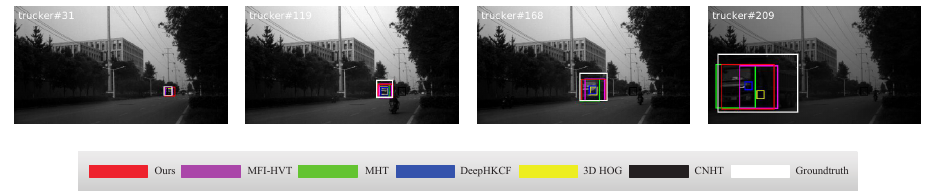
Figure 14. Qualitative results on the kangaroo sequence.